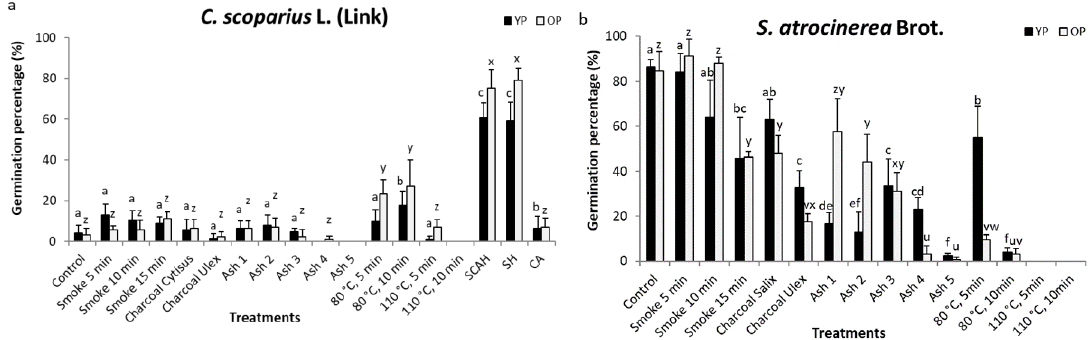
Figure 4. The germination percentages (x ± sd) reached by C. scoparius ( a ) and S. atrocinerea ( b ) seeds of young and old plants after fire treatments. Different letters on the bars indicate significant differences between the treatments and the control of the same mother plant ages.